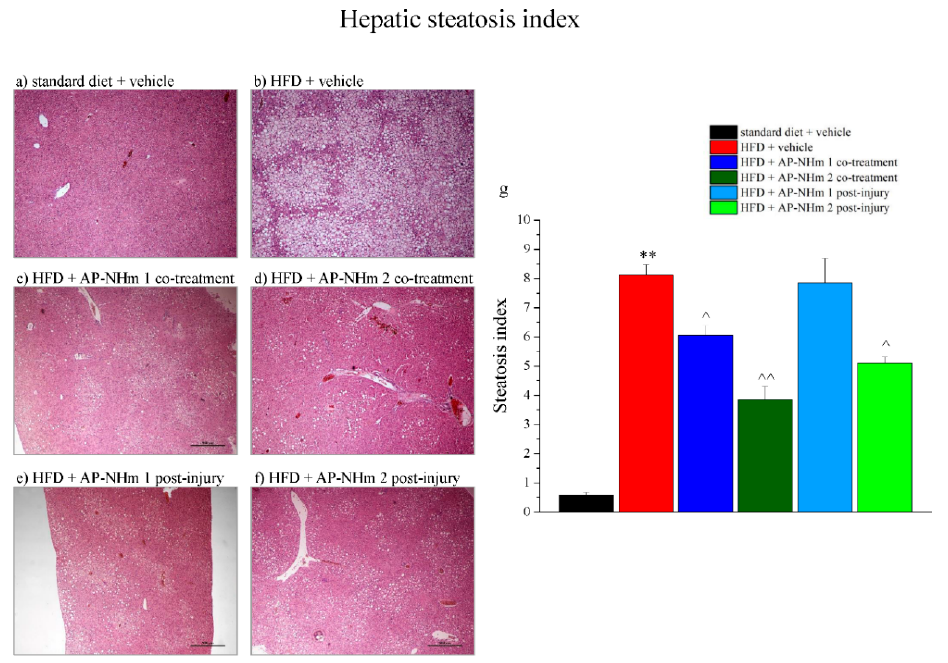
Figure 8. E ff ects of AP-NHm 1–2, in co-treatment or in post-injury treatment, on hepatic tissue and steatosis index. ( a – f ) Histology of tissue sections of hepatic tissue: ( a ) standard diet + vehicle, ( b ) HFD + vehicle, ( c ) HFD + AP-NHm 1 co-treatment, ( d ) HFD + AP-NHm 2 co-treatment, ( e ) HFD + AP-NHm 1 post-injury, ( f ) HFD + AP-NHm 2 post-injury; ( g ) steatosis index of each group of treatment. Each value represents the mean ± SEM of 12 mice per group. ** p < 0.01 vs. standard diet + vehicle, ˆ p < 0.05 and ˆˆ p < 0.01 vs. HFD + vehicle.